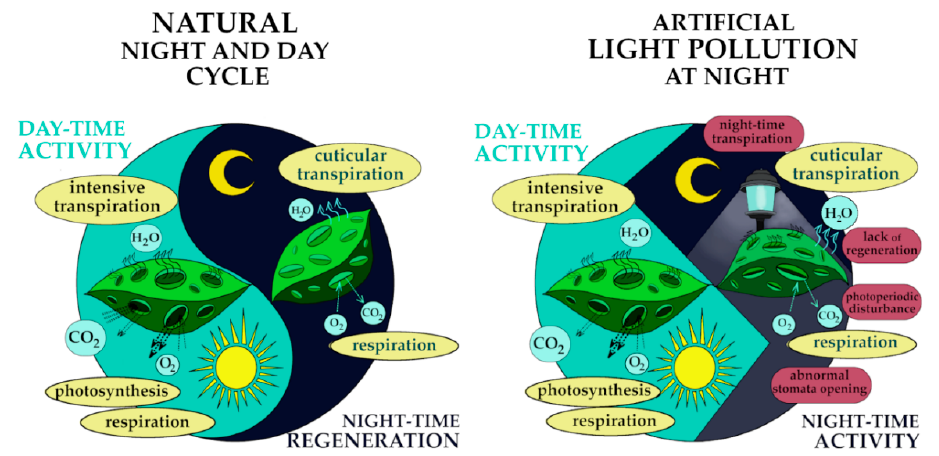
Figure 2. Natural night and day cycle and plant functioning disruption during artificial light pollution at